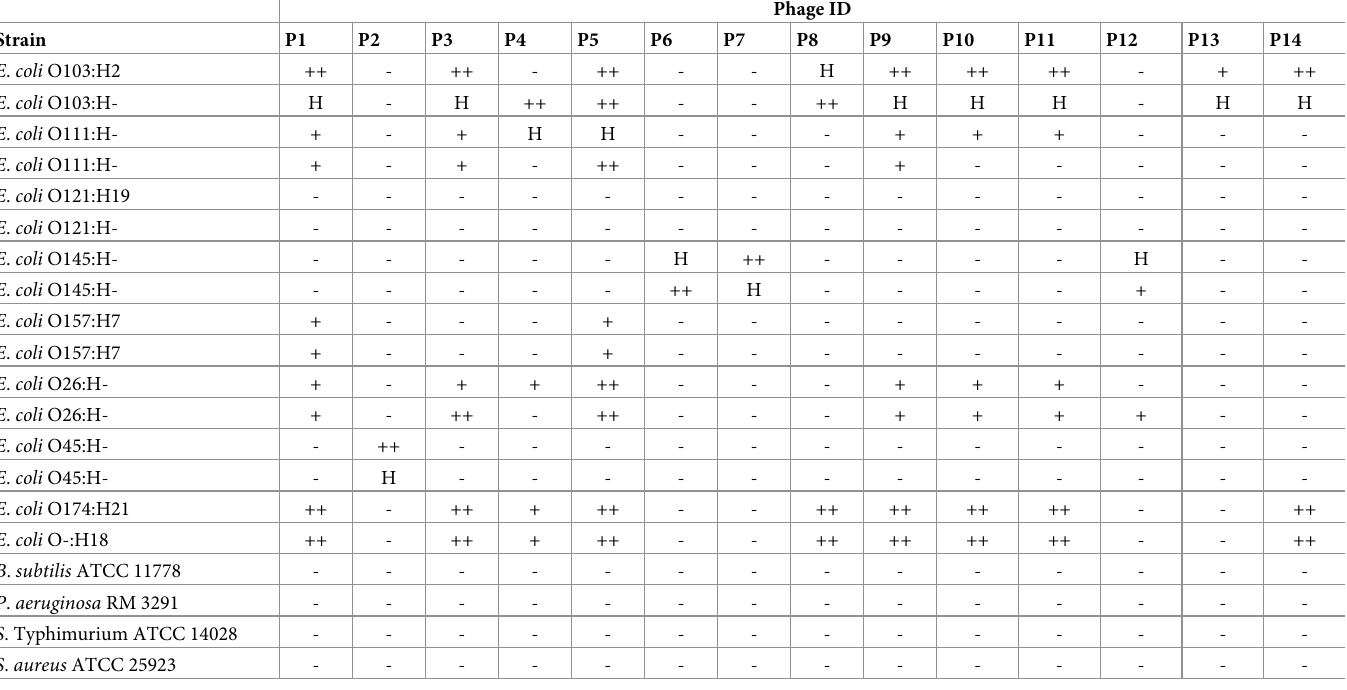
gies similar to those in the families Myoviridae (7 of 10 isolates), Siphoviridae (2 of 10 isolates), and Podoviridae (1 of 10 isolates) (Fig 1, Table 3). Molecular features of the phages ( stx screening, genome size & RFLP). All the isolated phages were negative of the virulence genes of stx1 and stx2 ; therefore, together with the host range test, these phages might have the potential to mitigate the target STEC strains. Table 2. Host range of the 14 isolated phages against various STEC, 1 Bacillus , 1 Pseudomonas , 2 Salmonella , and 2 non-O157 STEC strains- O174 and O, isolated in the current study, by the spot